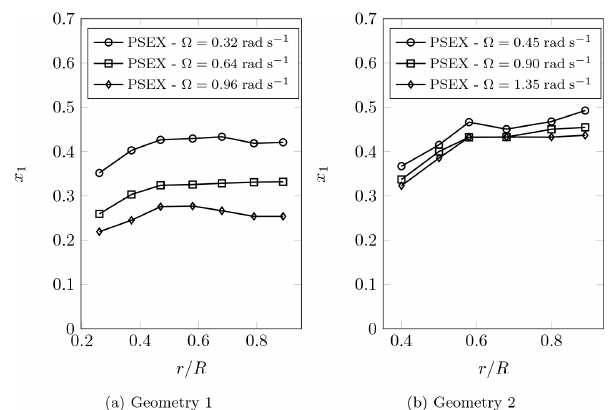
Figure 14. Transition locations for several rotation